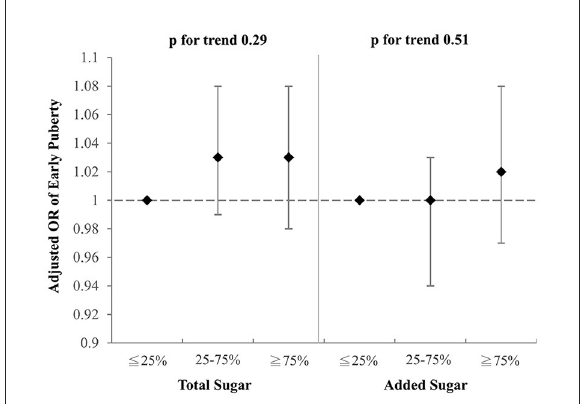
FIGURE2 Adjusted OR for early puberty due to the consumption of total sugar and added sugar from selected drinks (boys). Models were adjusted for BMI, parental educational level, family income, and household smoking.